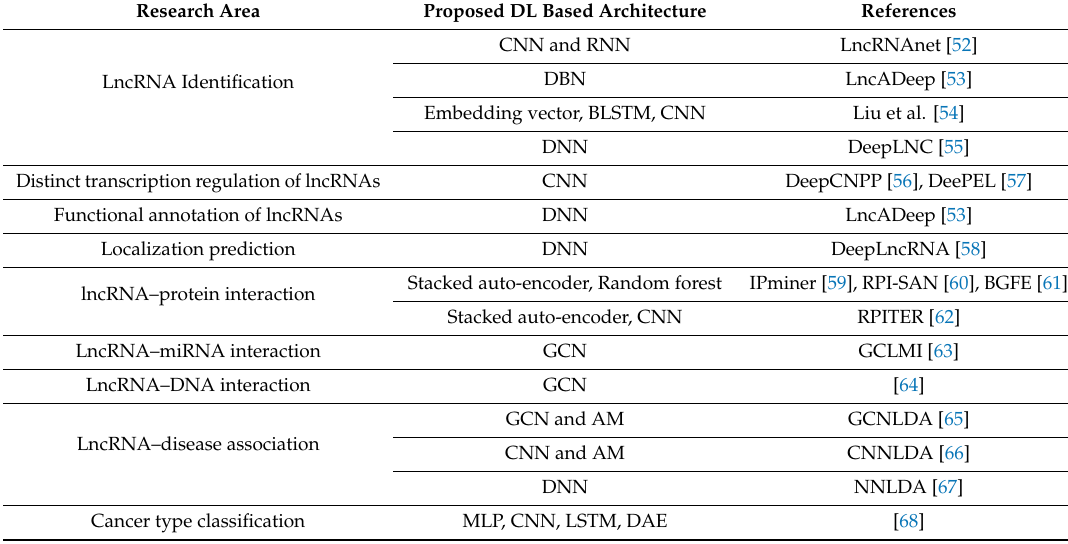
Table 1. List of deep learning (DL)-based architectures that have been employed to solve key questions in lncRNA